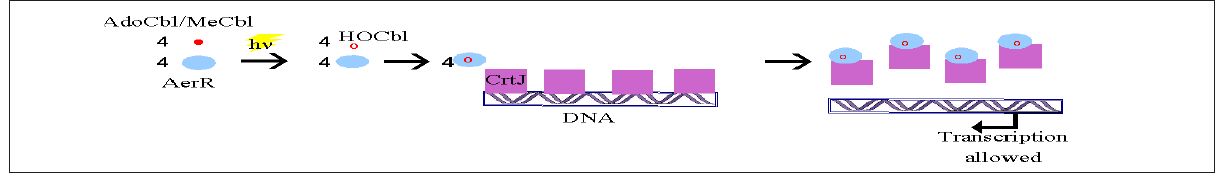
-dependent regulatory switch in Rhodobacter capsulatus . 33 In the dark, the CrtJ repressor binds to Figure 3: Model for the response to light of the B 12 DNA, preventing transcription. In the presence of light, AdoCbl or MeCbl is photolysed to give HOCbl which binds to AerR. The AerR–cobalamin complex binds to CrtJ and the CrtJ dissociates, allowing